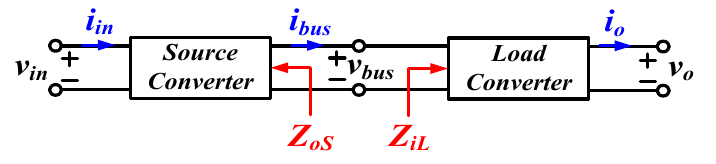
Figure 10. Dual-port network diagram of the series system. Four system transfer functions can be derived from Figure 10: ˆ 0 ˆ ( )